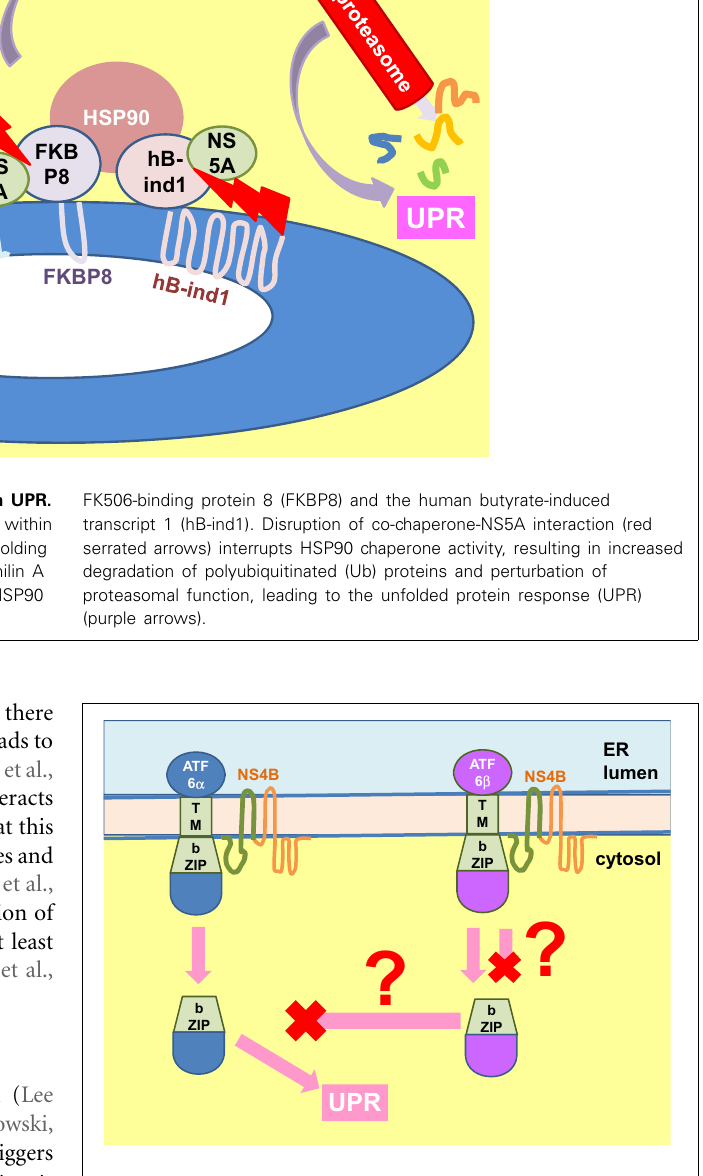
FIGURE 8 | NS4B interacts with ATF6 to modulate UPR. The hepatitis C virus (HCV) non-structural (NS) 4B protein binds to the b-ZIP and transmembrane (TM) domains of the activating factor 6 (ATF6) α and β (binding domains shown in green for both NS4B and ATF6). Binding of ATF6 α likely triggers its Golgi translocation and cleavage into an active transcription factor to mediate the unfolded protein response (UPR). The fate of NS4B binding to ATF6 β is unknown. It can either trigger or inhibit ATF6 β Golgi translocation and activation. The end result could be modulation of the UPR but whether ATF6 β is an inhibitor of ATF6 α is controversial. ER, endoplasmic